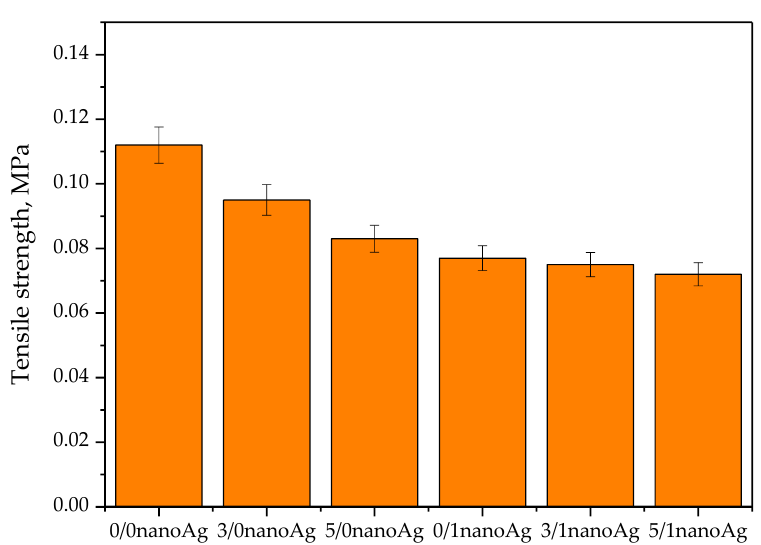
Figure 10. Results of tensile strength measurements of hydrogels (number of repetitions n = 3).